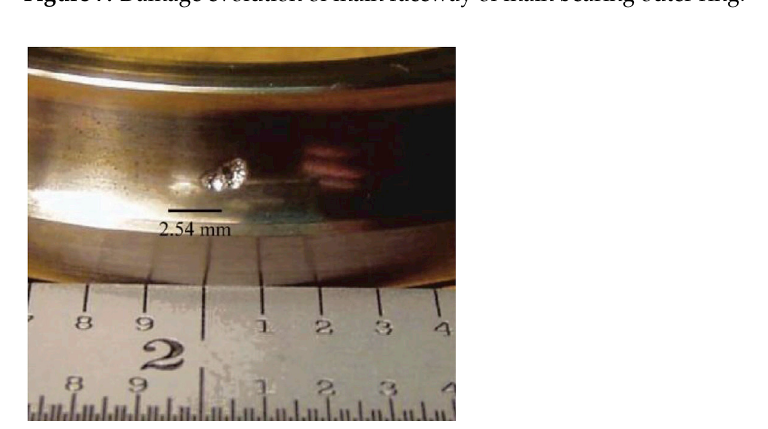
Figure 8. Typical fatigue spall formed on AISI-52100 in endurance life experiments (adapted from Reference [15]. Copyright 2018, Elsevier).